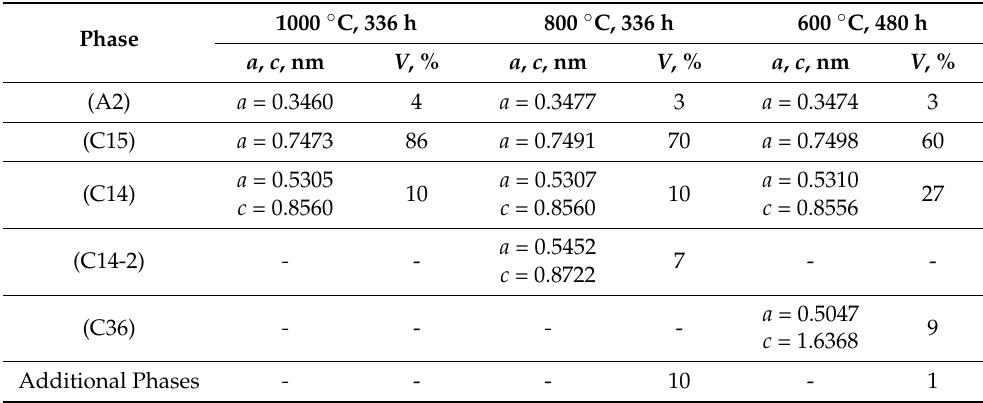
HPT, similar to heat treatment, has a significant effect on the structure and phase composition of the TiZrHfMoCrCo alloy. Figure 7 shows the loading curve (dependence of torsion torque on the plunger rotation angle) for the initial alloy. The HPT leads to the disappearance of the phase (C14) and provokes the appearance of another solid solution based on molybdenum (Mo)cub (A2-2) (Table 4). Annealing after the HPT changes the phase composition: phase (A2-2) disappears, and phase (C14) appears again. The amount of phase A2 is significantly reduced after annealing at 1000 ◦ C, com- pared with the initial state and state after HPT, and the Laves phases prevail again (C15) + (C14) = 80% like after annealing the as-cast alloy (Figure 8). The combination of HPT and annealing at 1000 ◦ C provides about 5% of additional phases. We believe that the appearance of additional phases (Tables 3 and 4) is due to the annealing in quartz ampoules, which does not provide a good vacuum. HPT does not lead to uniform grinding of phases (Figure 9a) and it is difficult to find a significant difference from the original structure (Figure 1a). The annealing after HPT leads (as can be expected) to the grain growth in constituent phases (Figure